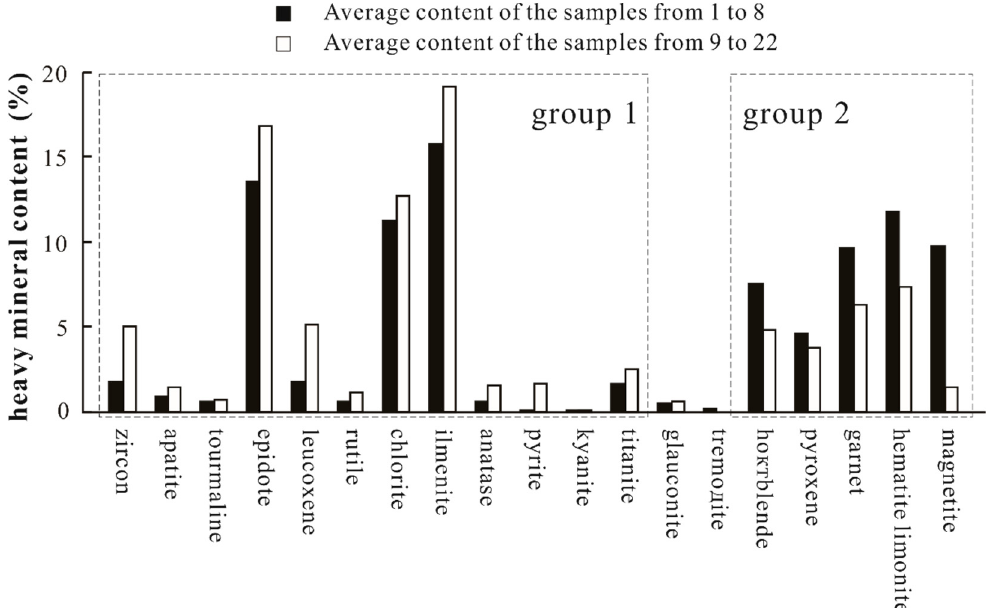
Figure 5. Comparison of heavy mineral assemblages between samples 22 to 9 and samples 8 to 1. In group 1, the average content of each heavy mineral of samples 8 to 1 is less than that of samples 22 to 9; in group 2, the average content of each heavy mineral of samples 8 to 1 is more than that of samples 22 to 9.